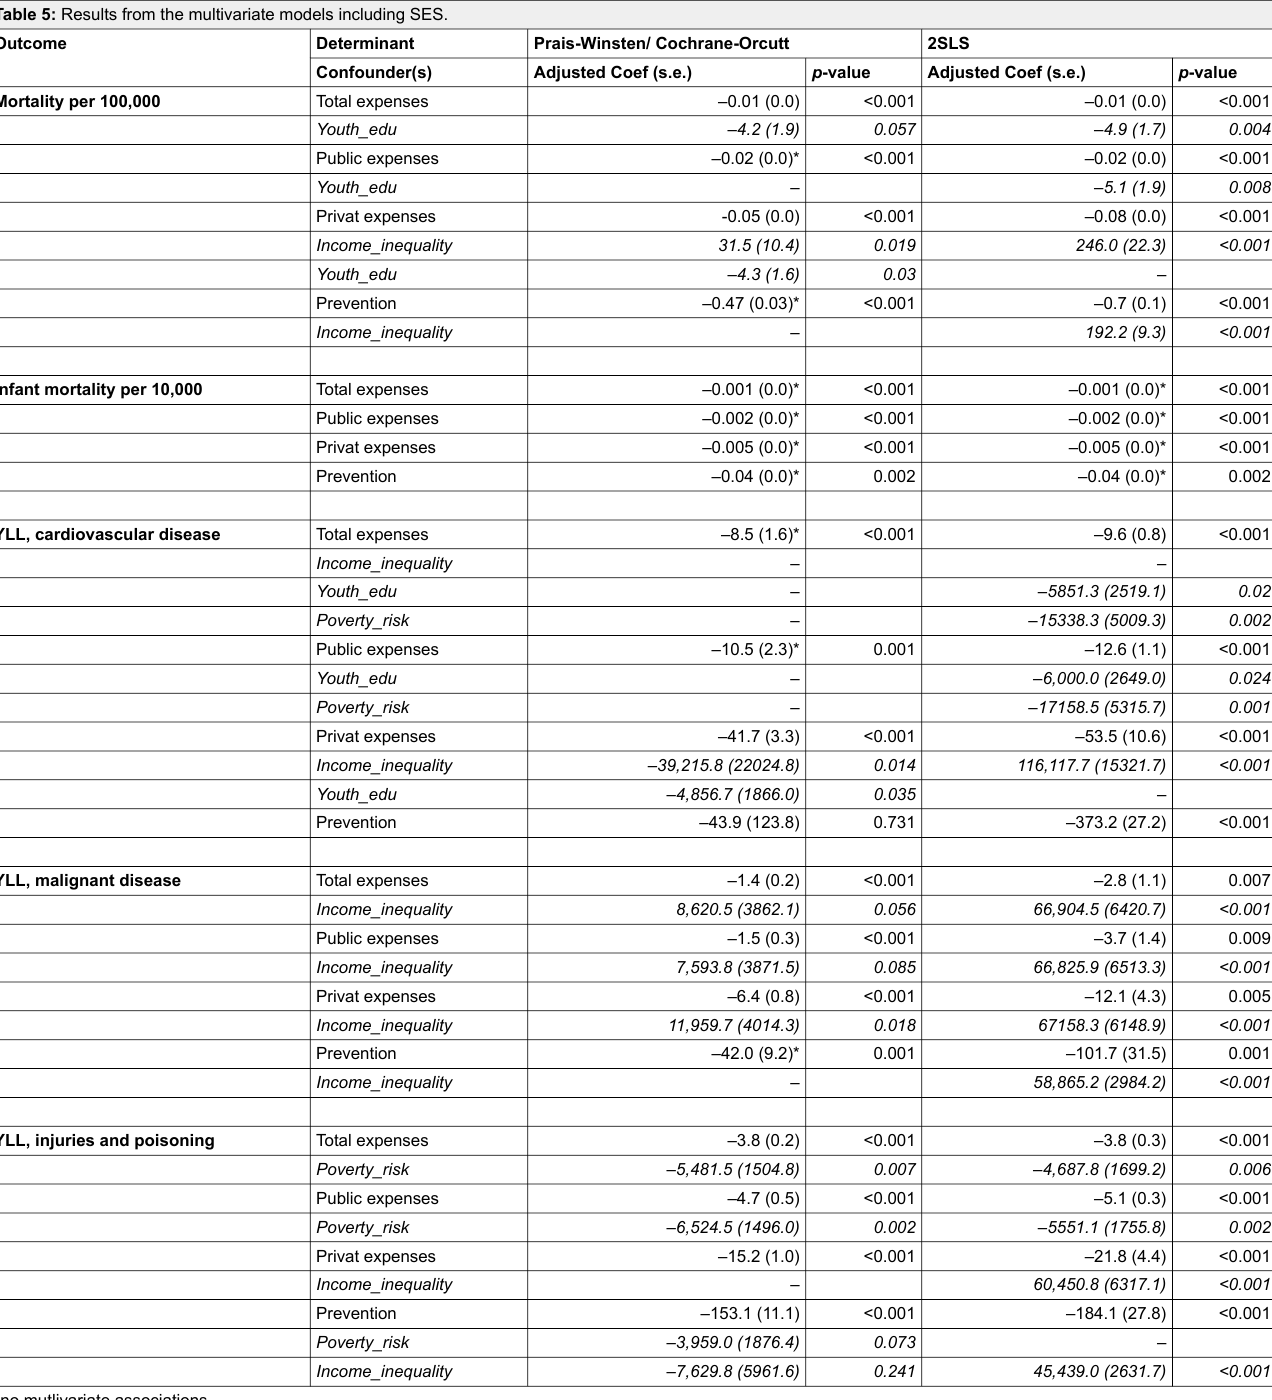
Table 5: Results from the multivariate models including SES.